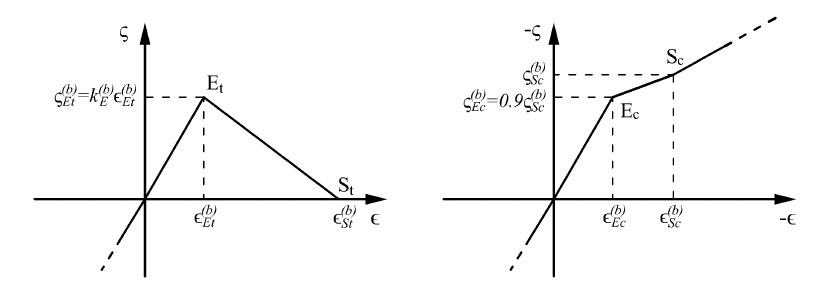
Figure 11. Spring stress–strain curves defined for traction and compression. For graphic reasons, the compressive stress–strain values are plotted as